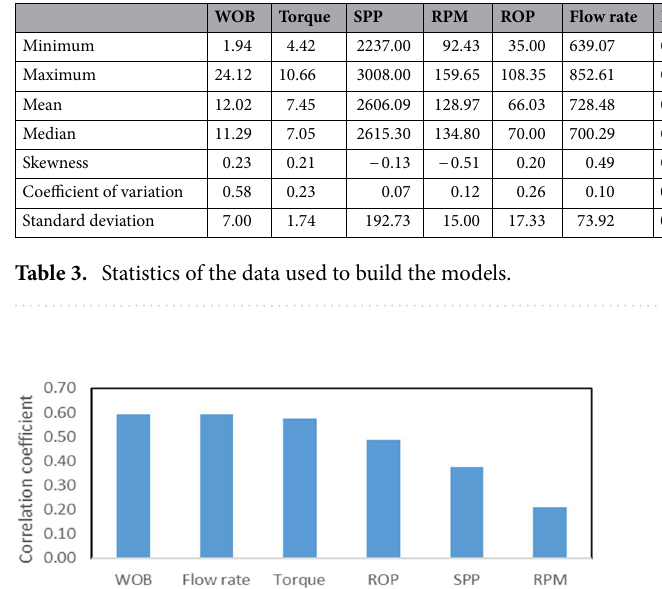
Figure 3. The correlation coefficient of drilling parameters with Poisson’s